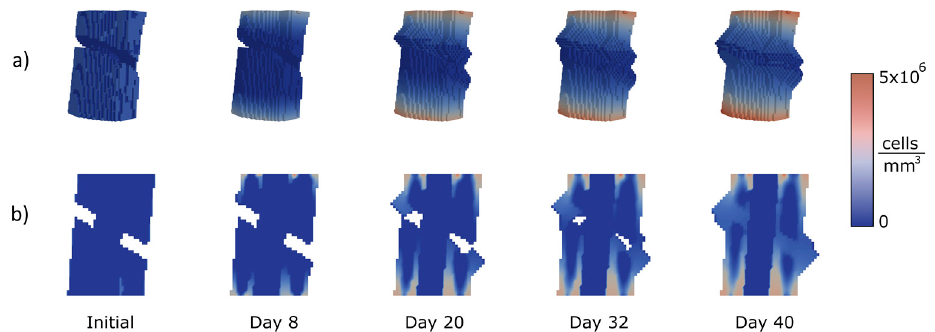
Figure 8. Calculation of concentrations (MSCs) and growth for an oblique fracture. 30° slope and 3mm height: ( a ) 3D view of the callus growth process; ( b ) sagittal section along femoral axis.